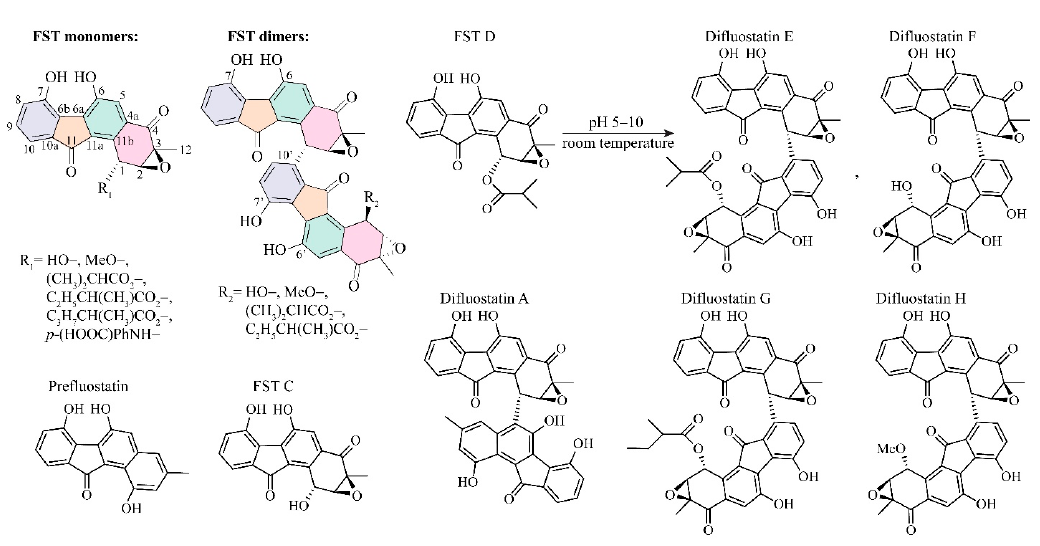
Figure 1. Structures of several discovered fluorostatin (FST) monomers and dimers, in which FST D undergoes spontaneous conjugation and yields Difluostatins E and F in aqueous solution. Unexpectedly, the recently biochemical and biosynthetic experiments indicated that fluostatin dimerization occurs without any auxiliary proteins [1]. The structural characterization of the end-products indicates there is regio- and enantioselectivity in the non-enzymatic reaction—the stereogenic center C1